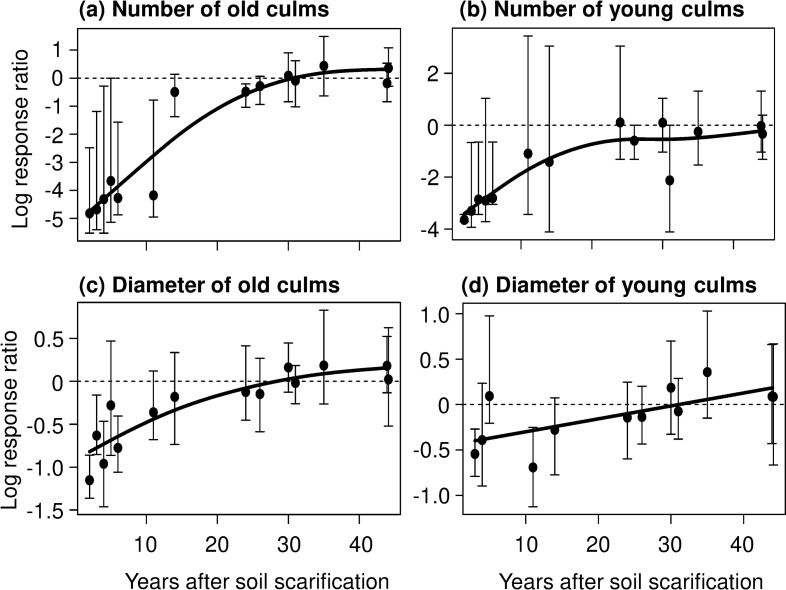
Log response ratios of number and culm diameter of old and young bamboo culms at 2 to 44 years after soil scarification.Error bars denote 95% CI from 1000 resampling iterations by bootstrap models, and solid curves indicate non-linear regressions by GAMs. Dotted lines indicate a neutral level of the effects of soil scarification (‘log response ratio’ = 0). The upper panels show plots of mean data, and the lower panels show individual culm data.